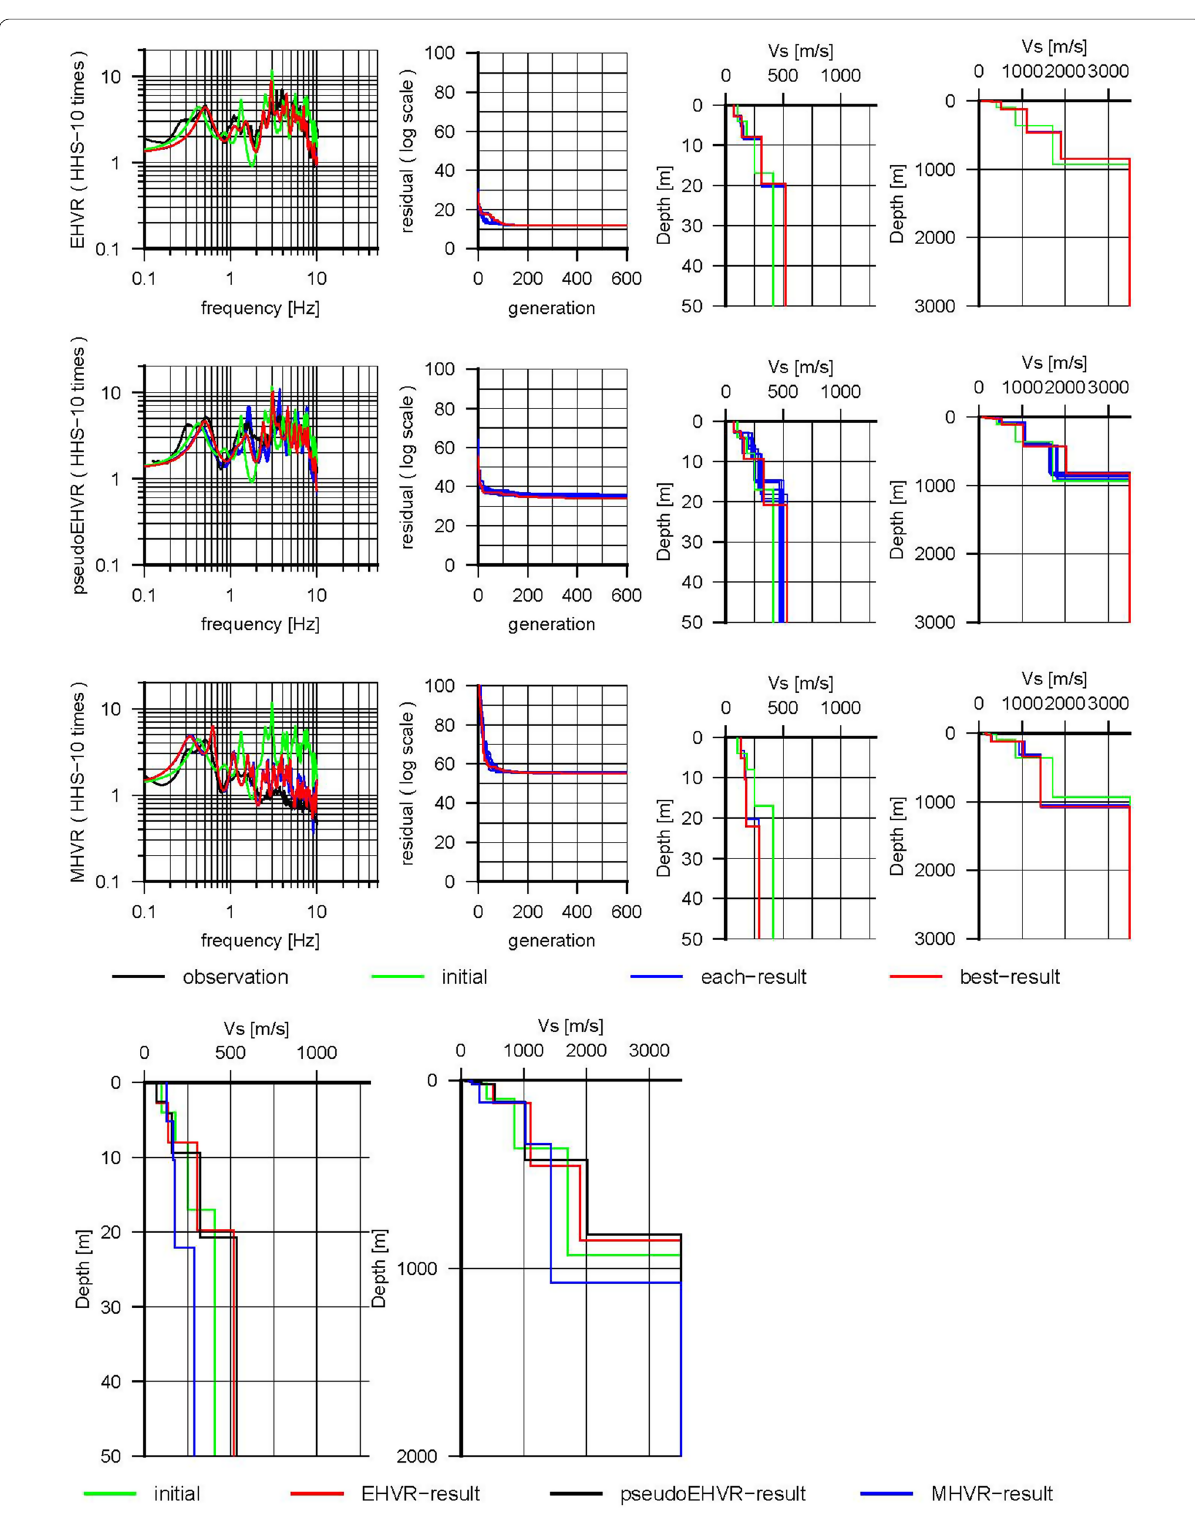
Fig. 20 Inversion results at MYG015 when a priori underground structure model of Satoh et al. (2001a) is used as the initial model. The target is (top row) EHVR, (second row) pEHVR, and (third row) MHVR. The left column shows comparison of HVRs, and the second left column shows process of residual convergence with respect to the generation. Two right columns show resultant shallow and deep velocity structures. The bottommost row shows comparison of inverted underground structures from three